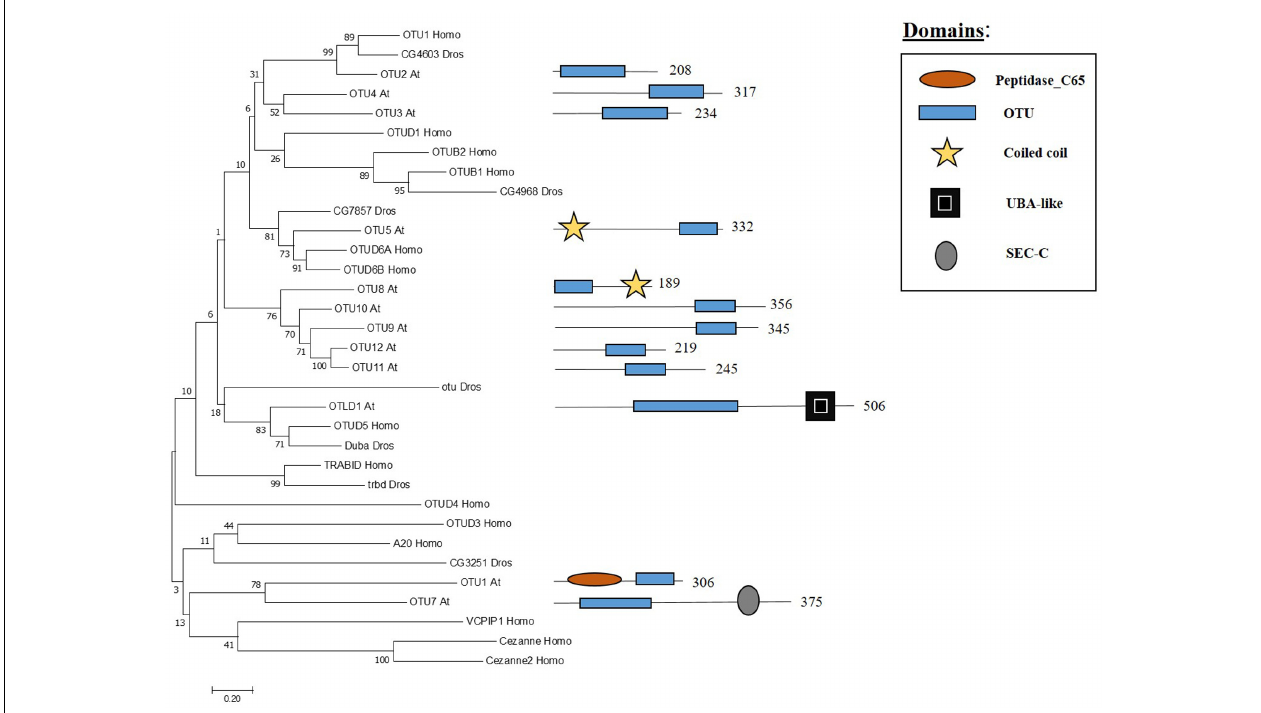
FIGURE 4 | Arabidopsis OTU family and the high sequence similarity proteins in Humans and Drosophila. Phylogenetic analysis showing the 12 members of the OUT family based on protein sequence percentage of similarity and their domains. The analysis was conducted in MEGA7 (Kumar et al., 2016). The tree was constructed by the Neighbor-Joining method with bootstrap resampling (5000 replicates). The numbers in the nodes indicate bootstrap values. The distances were computed using the Poisson method. Scale bars indicate units of the number of amino acid substitutions per site. The numbers in the domain representation indicate the amino acids